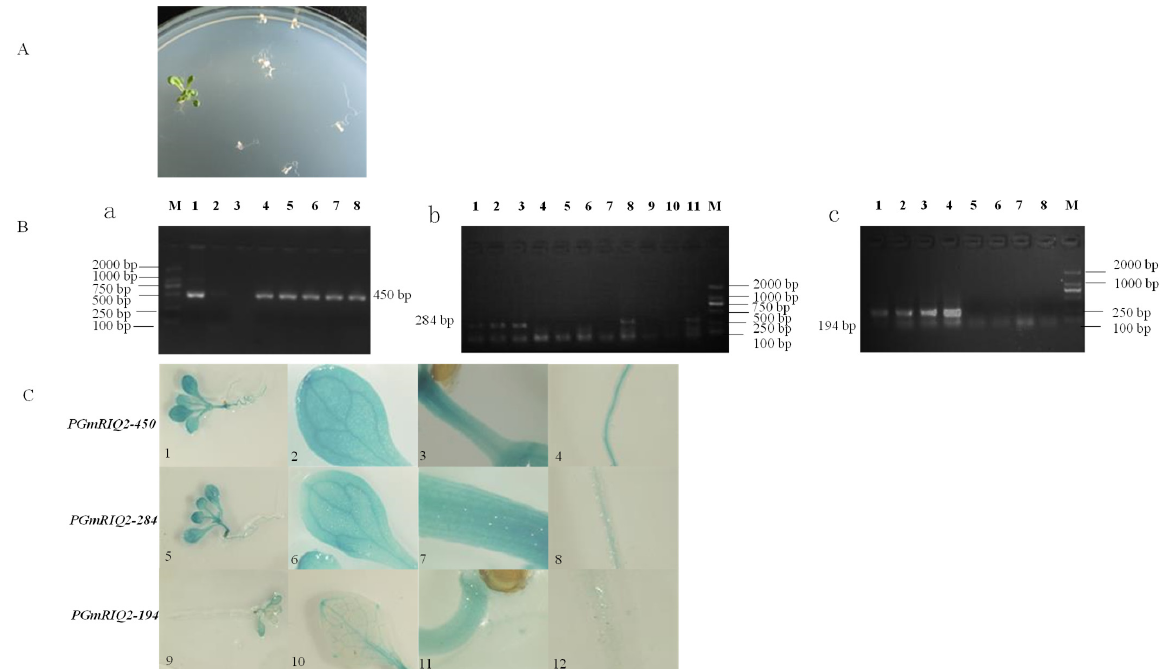
Figure 7. Detection of transgenic Arabidopsis with the GmRIQ2 gene deletion fragment promoter and GUS staining. ( A ) PPT resistance screening. ( B ) a and c: 1 – 8 PCR amplification bands with annealing